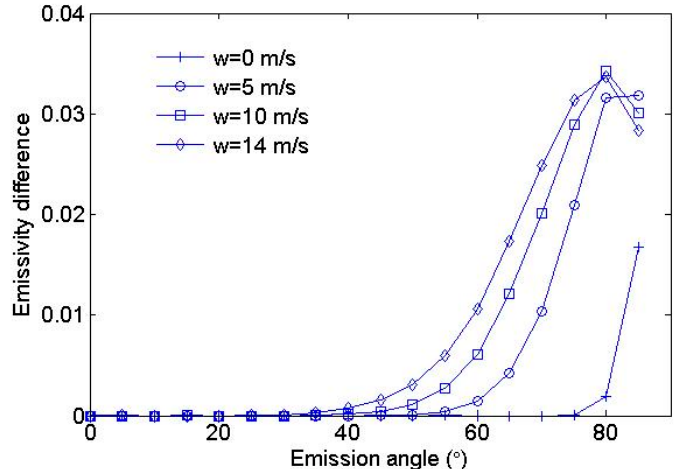
Figure 6. The fraction of reflected ray paths as a function of emission angle at four wind speeds. These curves quantify the fraction of the emitted ray paths that reflected off of one or more surface facets after being emitted by the source facet.